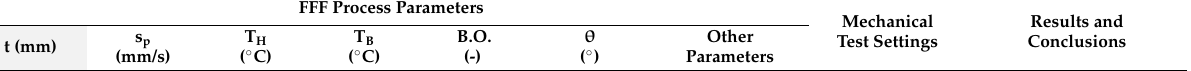
Table 2. The influence of the layer thickness on the mechanical properties of FFF-printed